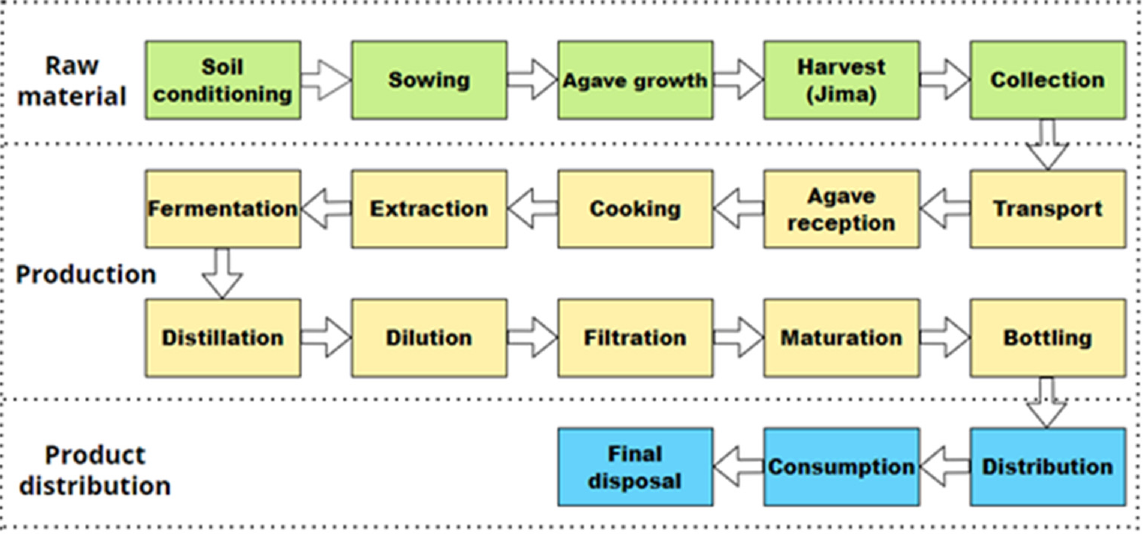
Figure 1. Supply chain of the agave–Tequila industry.